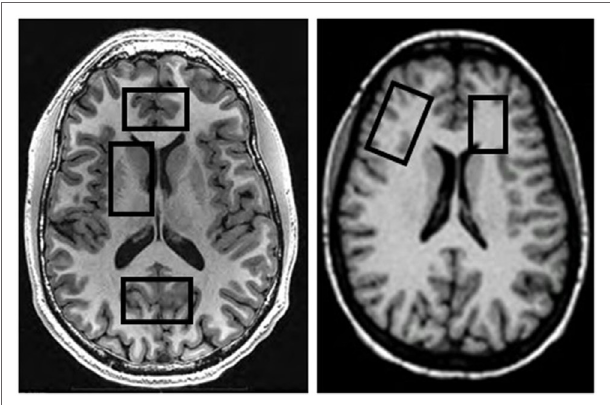
FigUre 1 | Typical locations of MRS volumes-of-interest on transverse